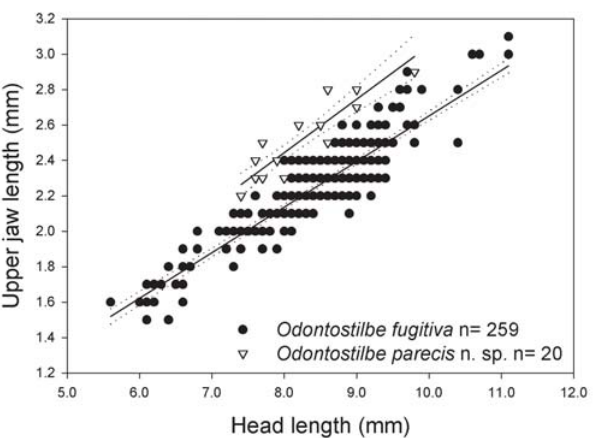
Fig. 25. Upper jaw lenght as a function of head length for males, females, and unsexed specimens of Odontostilbe fugitiva and Odontostilbe parecis .